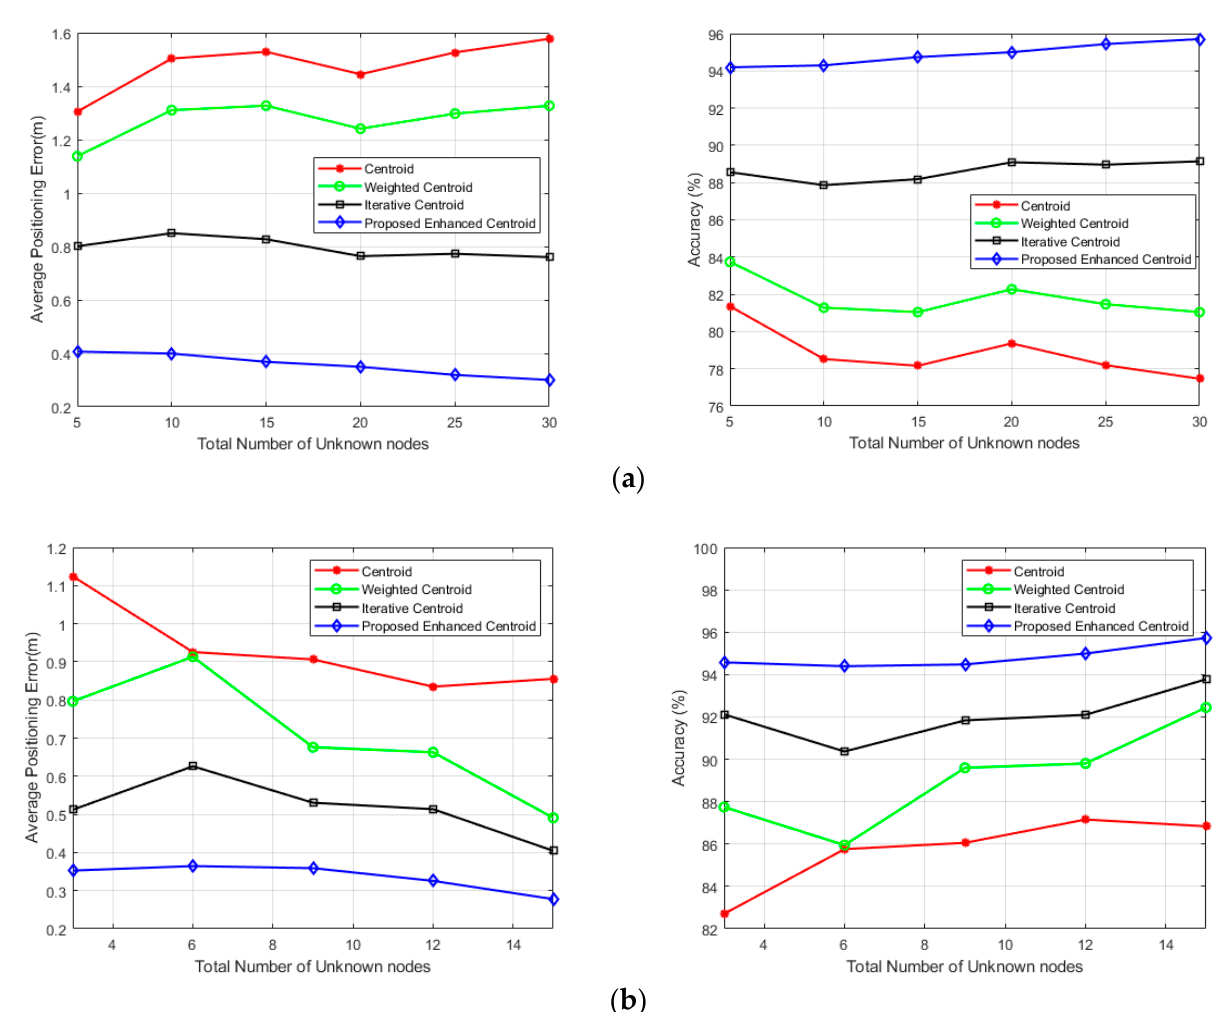
Figure 10. The number of unknown locations and its corresponding Average positioning error and Accuracy percentage: ( a ) The office room; ( b ) The corridor.